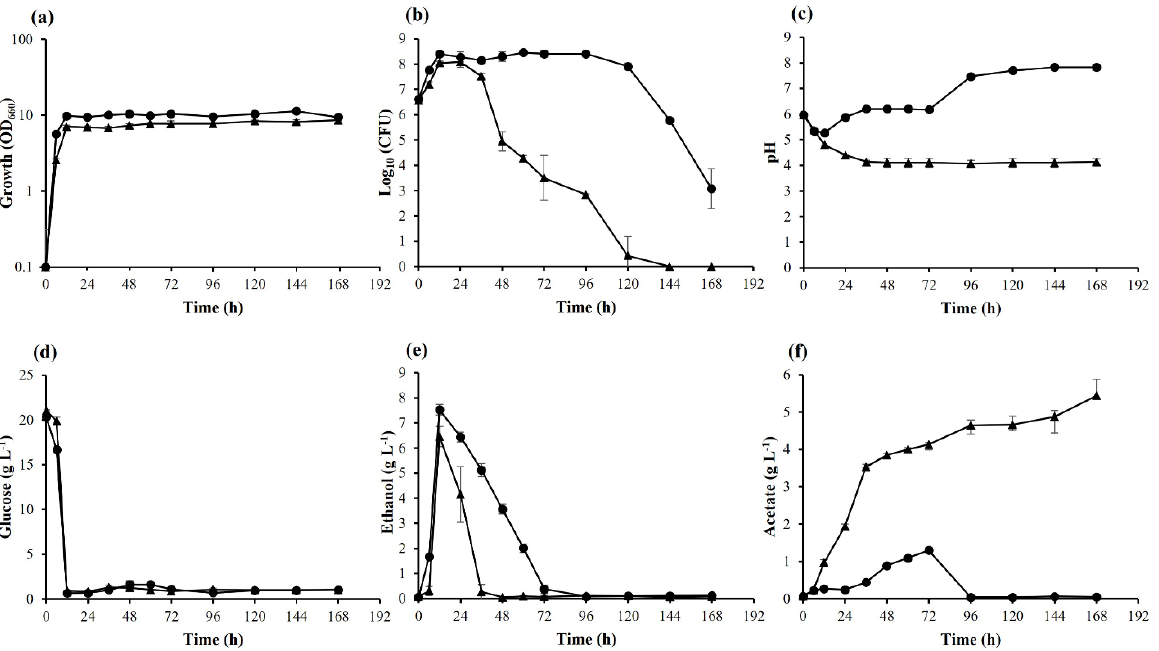
Figure 1. Growth, CFU, and fermentation parameters of K. marxianus DMKU 3-1042 in YPD medium at 30 ◦ C and 45 ◦ C. Cells were cultivated in YPD medium at 30 ◦ C ( • ) and 45 ◦ C ( (cid:78) ) under a shaking condition at 160 rpm for 7 days. Growth ( a ) was determined by measuring OD 660 . CFUs ( b ) were determined by counting colonies on YPD plates incubated at 30 ◦ C. pH ( c ) was measured by using a twin pH meter. Glucose ( d ), ethanol ( e ), and acetate ( f ) were determined by HPLC. Error bars represent ± SD of values from experiments performed in